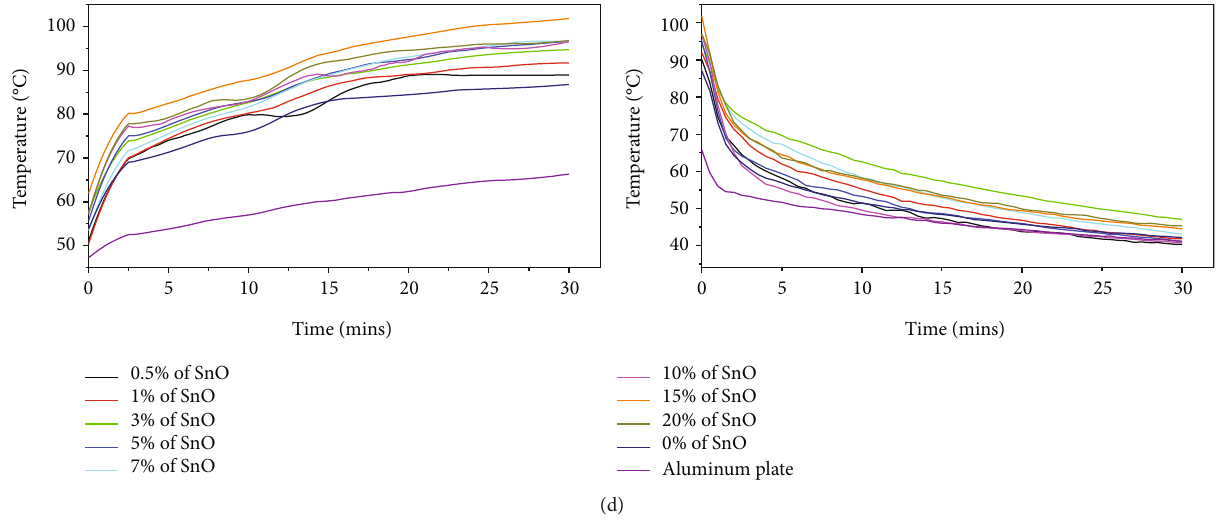
Figure 6: E ff ect on absorber temperature at irradiation exposure of (a) 200W/m 2 , (b) 400W/m 2 , (c) 800W/m 2 , and (d) 1000W/m 2 , and temperature-drop pro fi le (Ai, Bi, Ci, and Di).